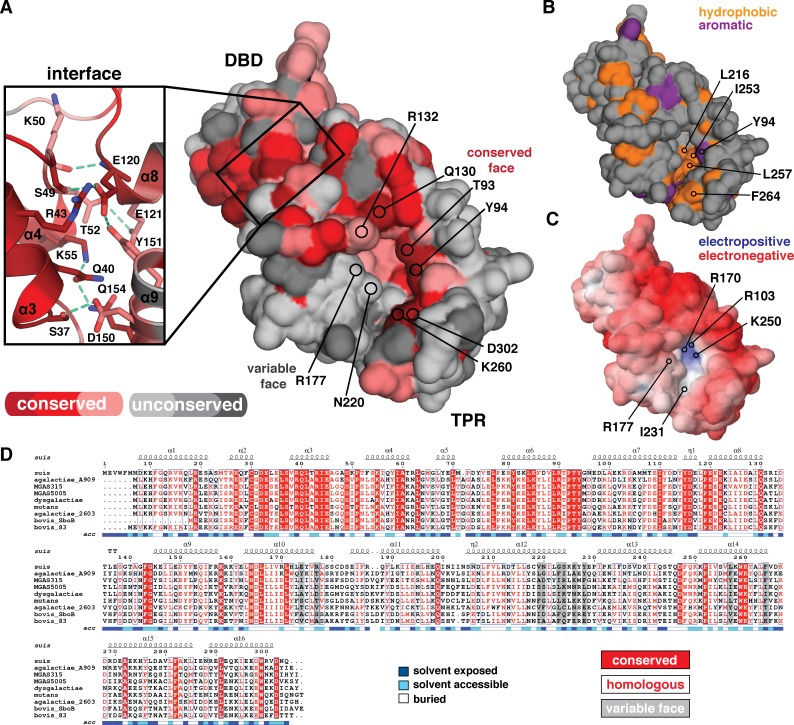
The molecular surface properties of apo-ComR S. suis.(A) Solvent accessible surface representation colored by amino-acid conservation using the Consurf server and the bacterial strains used in this study. Darker red indicates increased conservation with dark red showing completely conserved positions. Unconserved residues are shown in grey, with dark grey as least conserved. The XIP binding site consists of a conserved surface and a variable surface. Residues of interest are indicated by position and labeled. The inset shows the DBD and TPR domain interface that consists of highly conserved residues, with hydrogen bonds indicated by a dashed green line. (B) The solvent accessible hydrophobic residues of the ComR S. suis surface are highlighted in orange (C) Electrostatic surface potential as calculated by APBS with a contour of -10 kT/e to 10 kT/e. (D) Alignment of ComR S. suis with all species studied in this work. Secondary structure is annotated as Fig 4. Conserved and homologous residues are highlighted in red with the XIP variable face residues in a gray box. The alignment was generated by Clustal Omega and Espript3